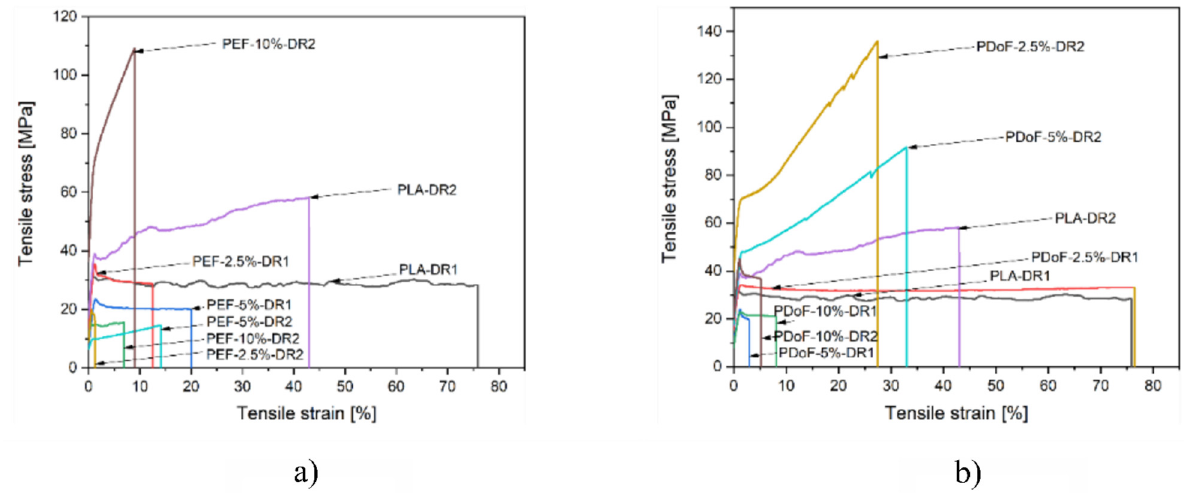
Figure 10. Representative stress–strain curves of the ( a ) PLA/PEF and ( b ) PLA/PDoF fiber blends drawn at DR = 1 and DR = 2.